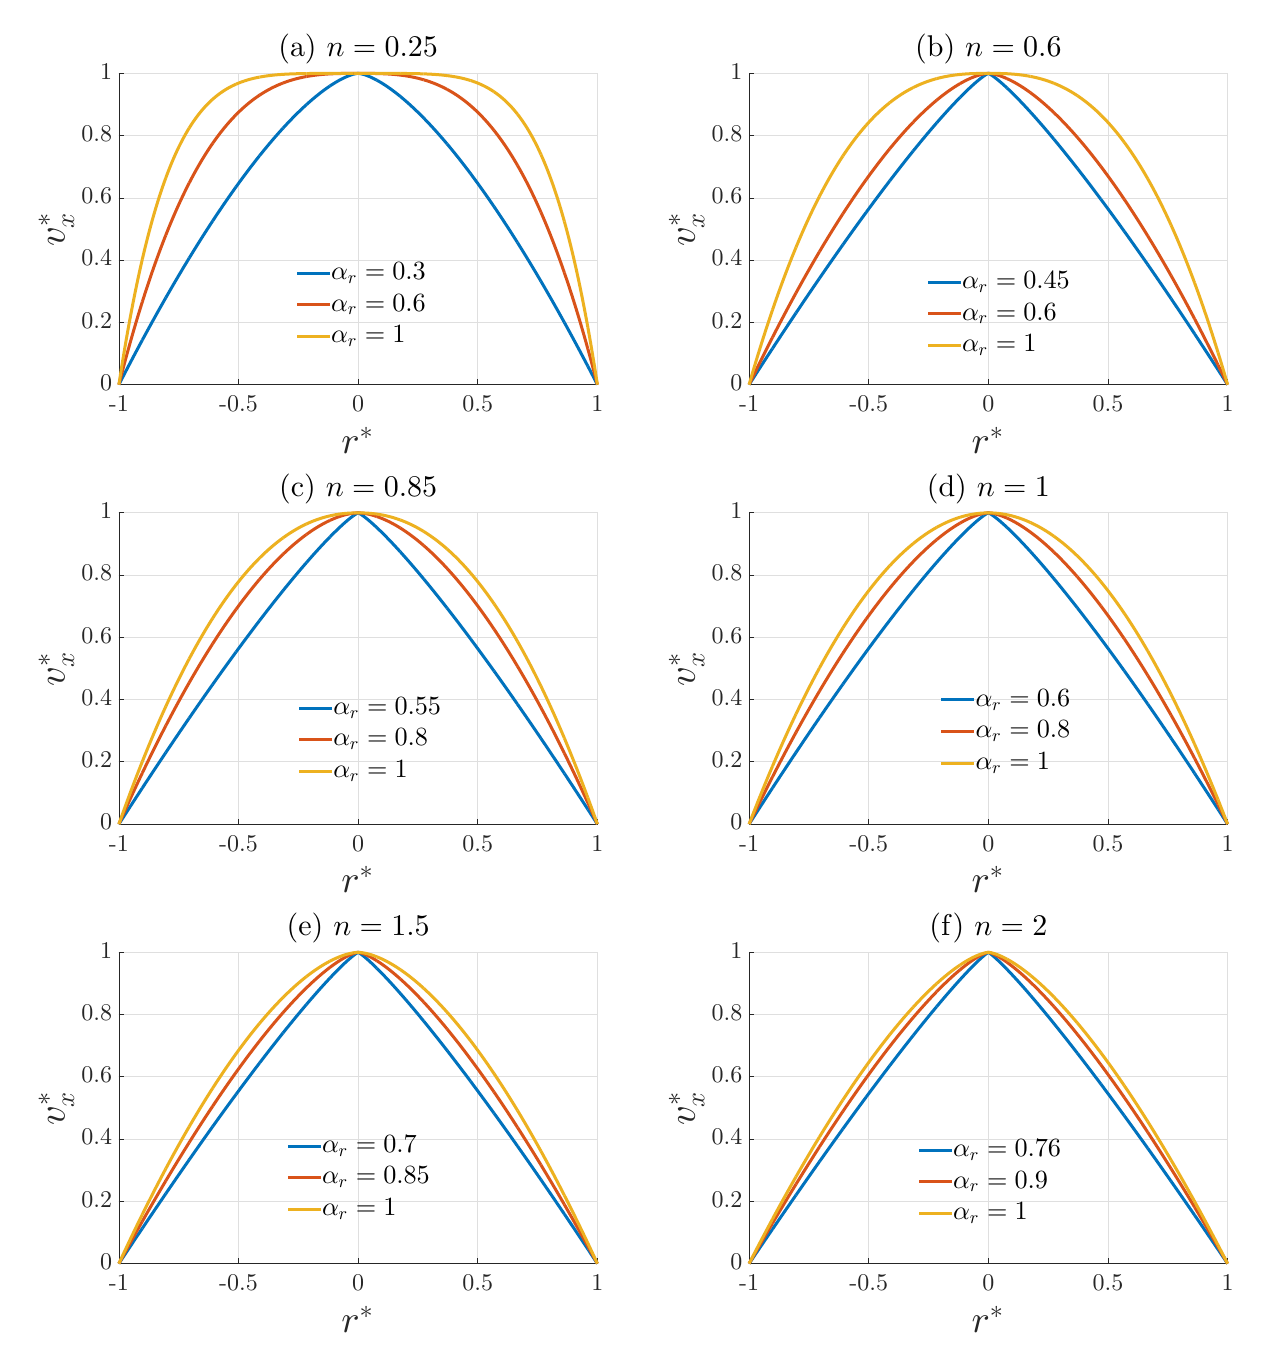
Figure 4. Plot of the normalized velocity profile v ∗ x = v x / V max , where v x is defined by Equation (31), r ∗ = r / R and the permitted values of α r in ( a ) 0.2 < α r ≤ 1, ( b ) 0.375 < α r ≤ 1, ( c ) 0.46 < α r ≤ 1, ( d ) 0.5 < α r ≤ 1, ( e ) 0.6 < α r ≤ 1 and ( f ) 0.66 < α r ≤